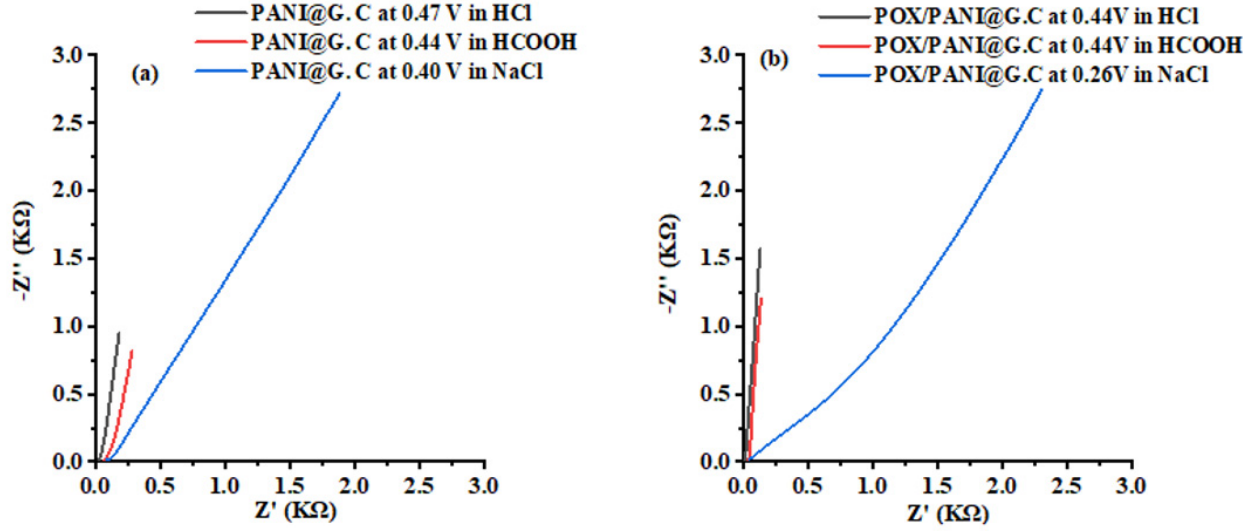
Figure 3. EIS of PANI@G.C ( a ) and POX/PANI@G.C ( b ) was measured at OCP in different electro- lytes.